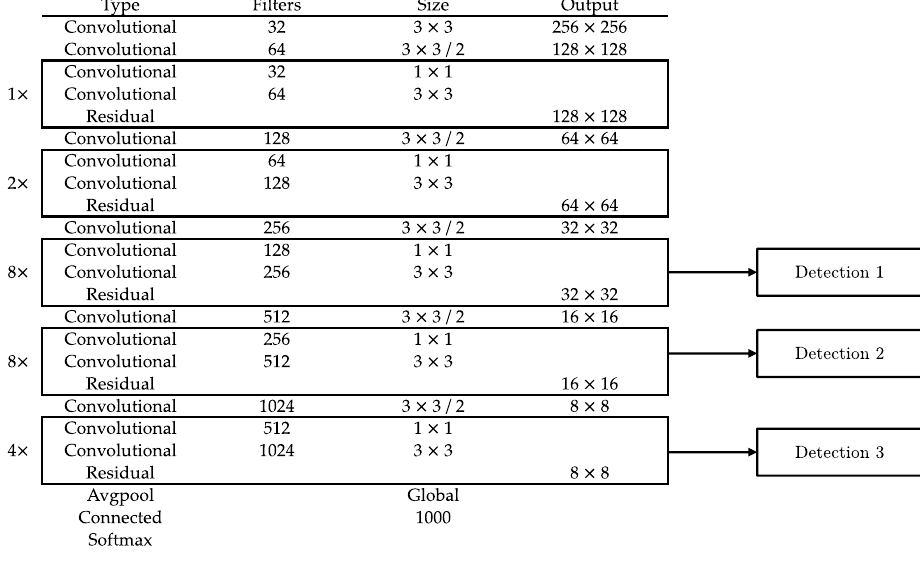
Figure 6. Convolutional set. YOLOV3 [31] predicts a target value for each bounding box using logistic regression. The bounding box prediction consists of five components, as we see in Equation (4). y = (𝑥 1 , 𝑦 1 , 𝑥 2 , 𝑦 2 , 𝑐𝑜𝑛𝑓𝑖𝑑𝑒𝑛𝑐𝑒) (4) where (𝑥 1 , 𝑦 1 , 𝑥 2 , 𝑦 2 ) coordinates represent the center of the box concerning the location of the grid cell. These coordinates are normalized between 0 and 1. The confidence value indicates how likely it is that the box contains an object and how accurate the bounding box is. The pre-segmentation phase is a critical stage for obtaining accurate segmentation results. For comparison purposes, it should be included in the results stage. 3.3. Segmentation The segmentation phase aims to refine or adjust the region bounded by the coordi- nates from pre-segmentation to select a region of bird and no-bird. Figure 7a shows an example of the segmentation phase proposed to delineate regions for birds and non-birds based on the coordinates obtained by pre-segmentation. The adjustment of the pre-seg- mentation coordinates is defined by two configurations: Configuration 1: the pre-segmentation coordinates are reduced by 50%. Pixels within the range of Configuration 1 are classified as birds (Figure 7b). The coordinates of Config- uration 1 are described below: Given a coordinate vector, Equation (4), with values [𝑥 1 , 𝑦 1 , 𝑥 2 , 𝑦 2 ] , the width of the region, 𝑤 𝑥 = 𝑥 2 − 𝑥 1 , and the height of the region, ℎ 𝑦 = 𝑦 2 − 𝑦 1 , are determined, and the region of the bird is defined in Equations (5) – (7):